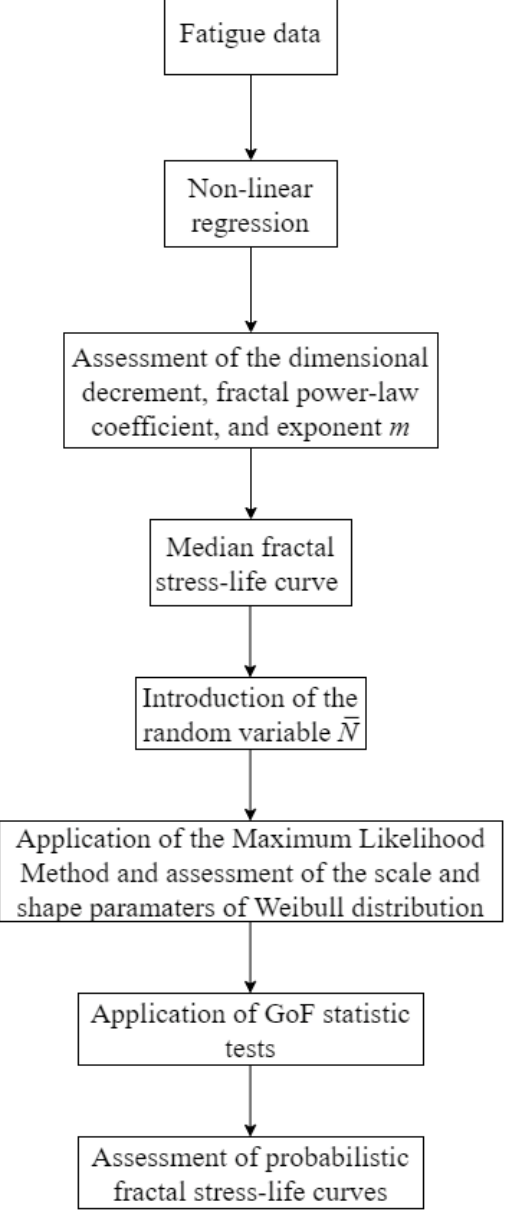
Figure 5. Flowchart for the determination of the free parameters of the fractal